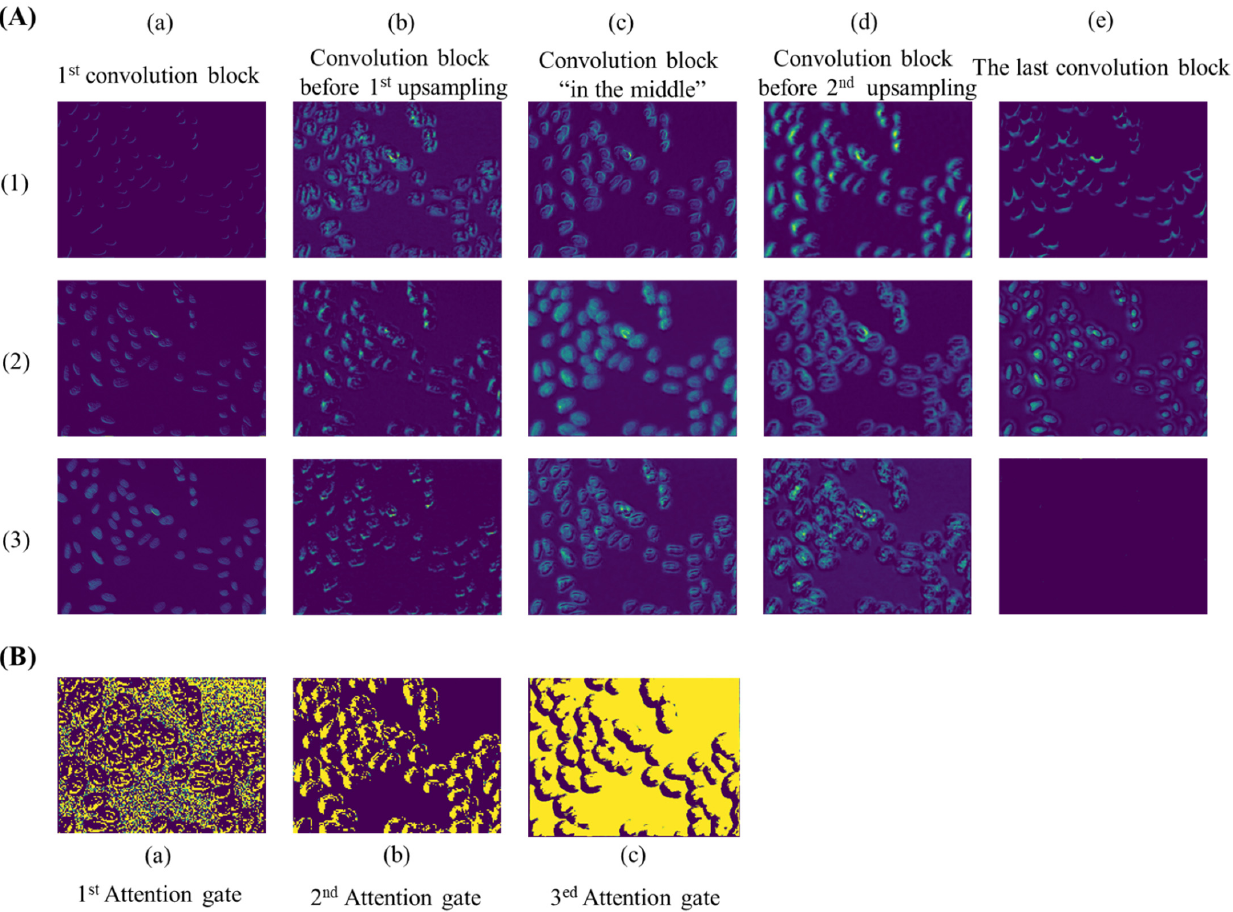
Figure 4. Visualization of feature maps extracted by convolution layers at different depths of ASW- Net. ( A ): (a) to (e), from left to right, represent the features extracted by the first convolution block, the convolution block before the first up-sampling, the convolution block in the middle, the convolution block before the second up-sampling, and the last convolution block, respectively. ( B ): (a) to (c), from left to right, represent the features extracted by the first, the second, and the third attention gate .